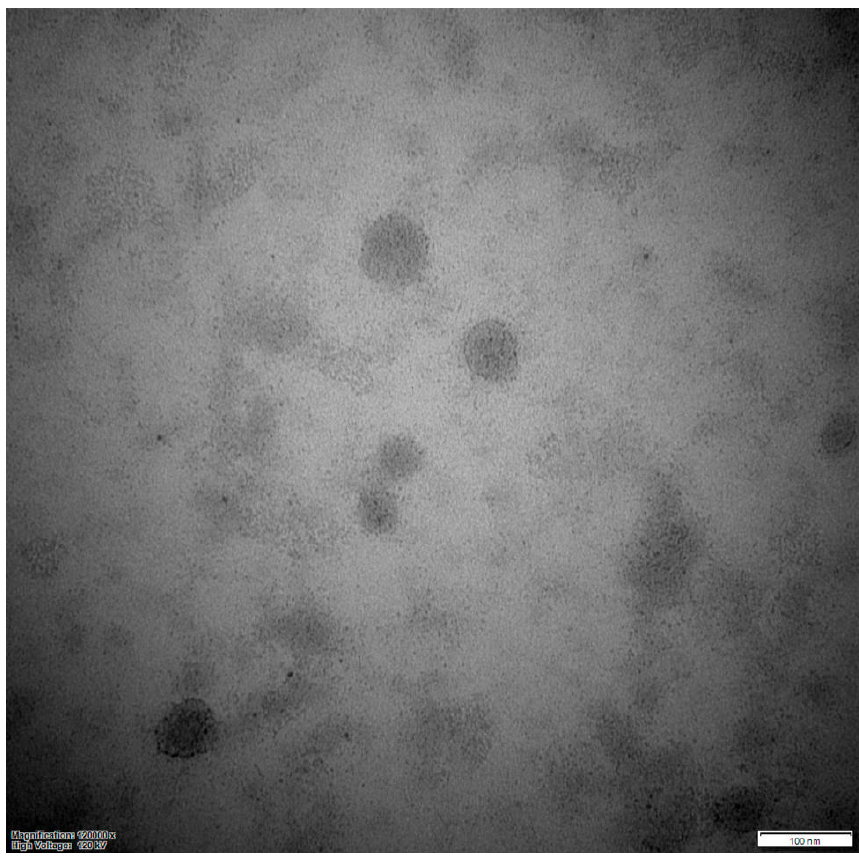
Figure 1. Transmission electron micrograph of exosomes isolated from serum. The morphology is observed by negative staining.